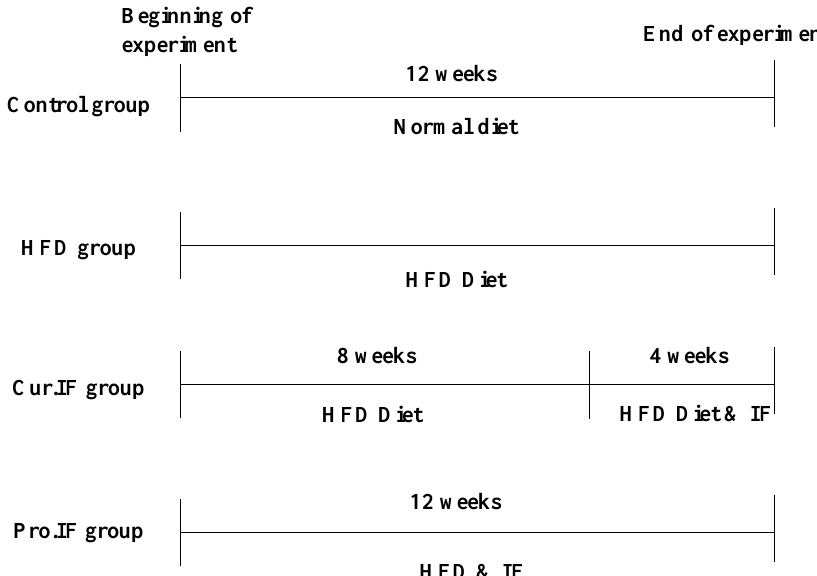
Figure 1. Diagram representing the experimental design. Rats were fed either basal (normal control group) diet; HFD; HFD and subjected to intermittent fasting (pro. IF) for 12 weeks, or HFD for 12 weeks and subjected to intermittent fasting (cur. IF) alternating with HFD during last 4 weeks. HFD means high-fat diet; pro. IF means prophylactic intermittent fasting while cur. IF means curative intermittent fasting.